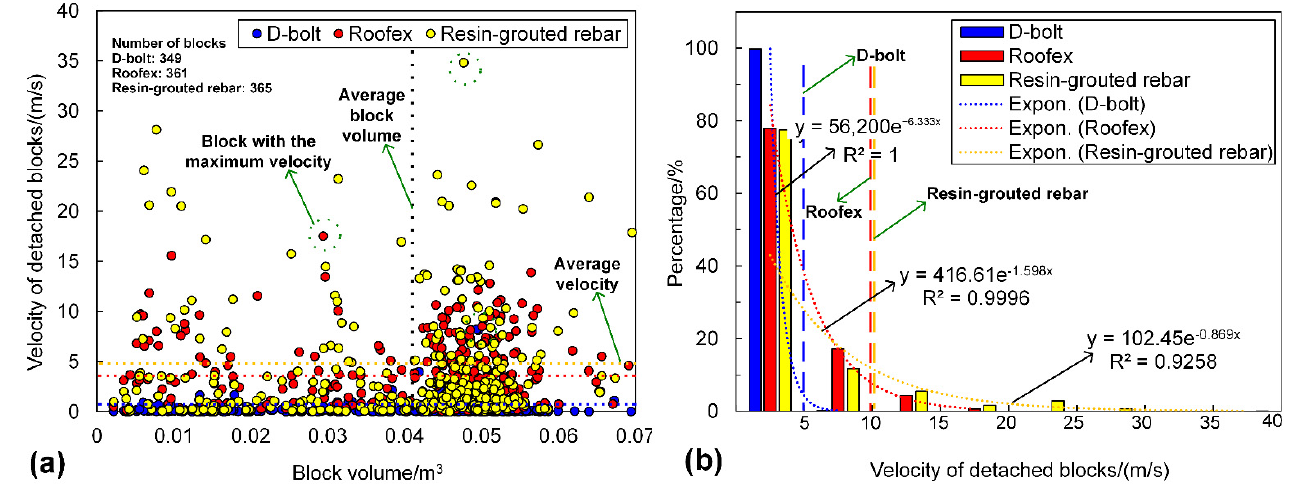
Figure 15. ( a ) is the velocity of all detached blocks versus block volume. ( b ) is the velocity distribution of all detached blocks. e is the Euler's number.